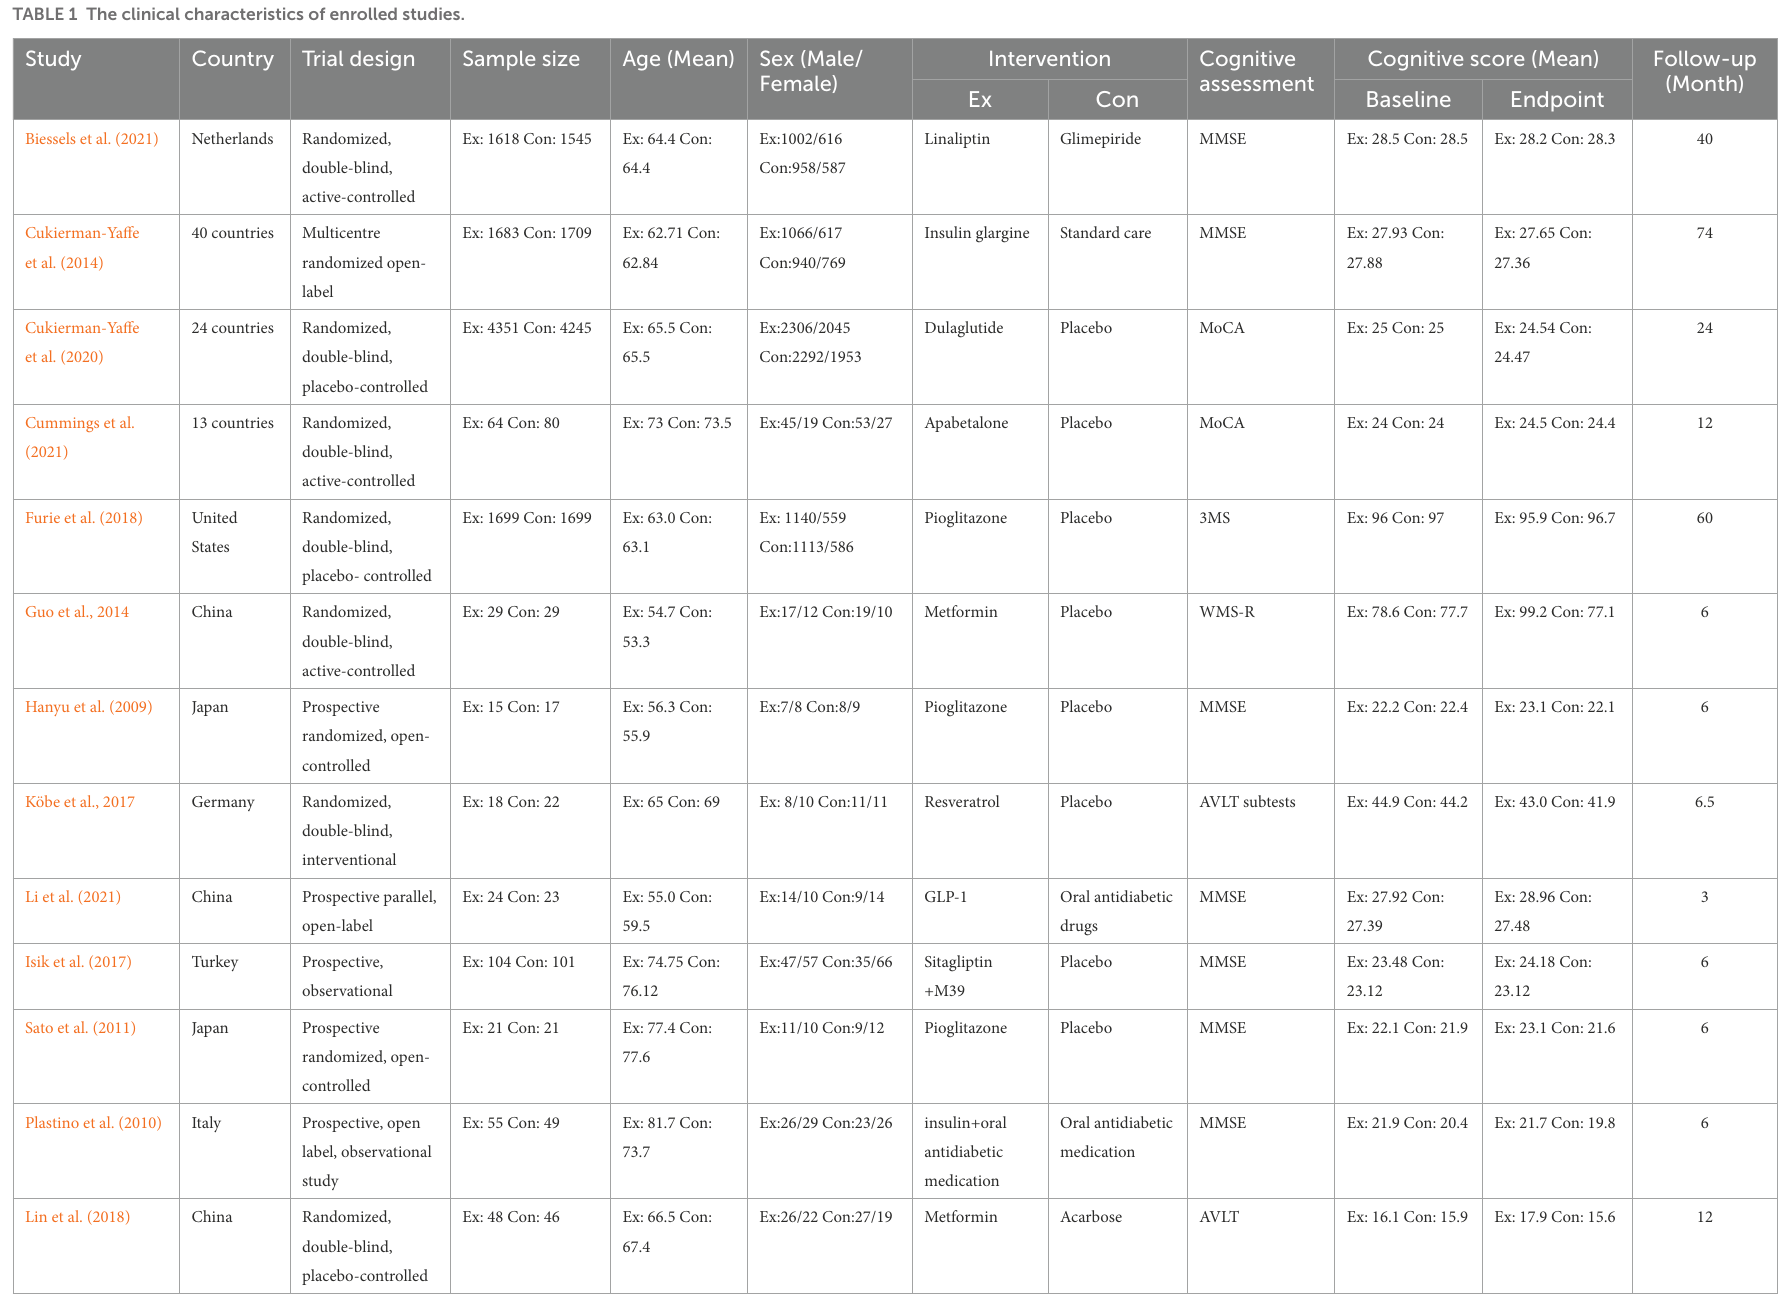
TABLE 1 The clinical characteristics of enrolled